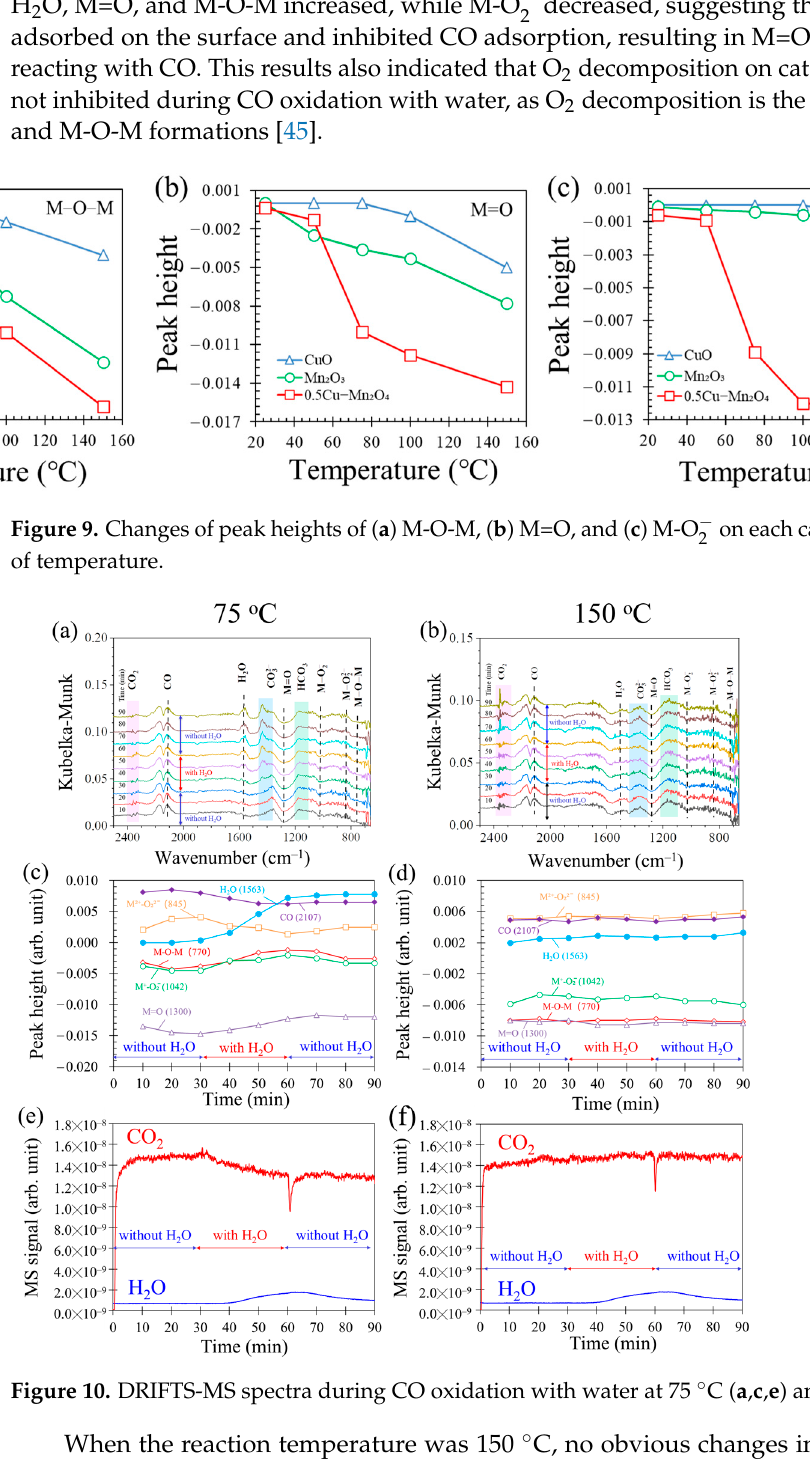
Figure 10. DRIFTS-MS spectra during CO oxidation with water at 75 °C ( a , c , e ) and 150 °C ( b , d , f